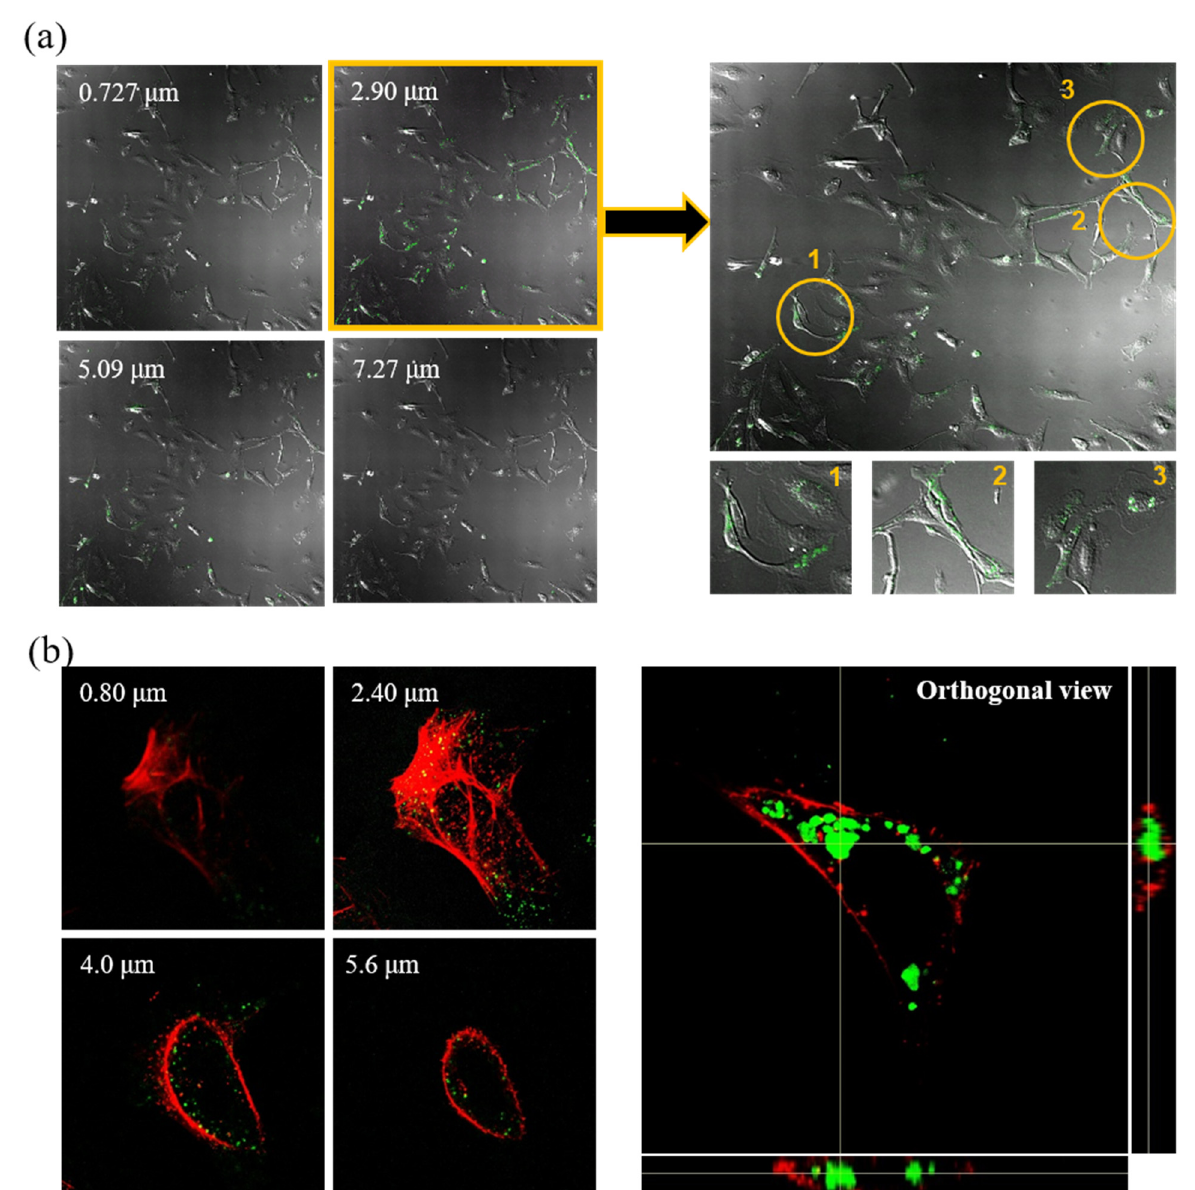
Figure 3. Confocal laser scanning microscopic images of LX2 cells treated with FITC-BSA LTU NPs: ( a ) sliced images with different cell depths and enlarged image at cell depth of 2.90 μ m; ( b ) sliced images using rhodamine phalloidin as a dye for actin and its orthogonal view.